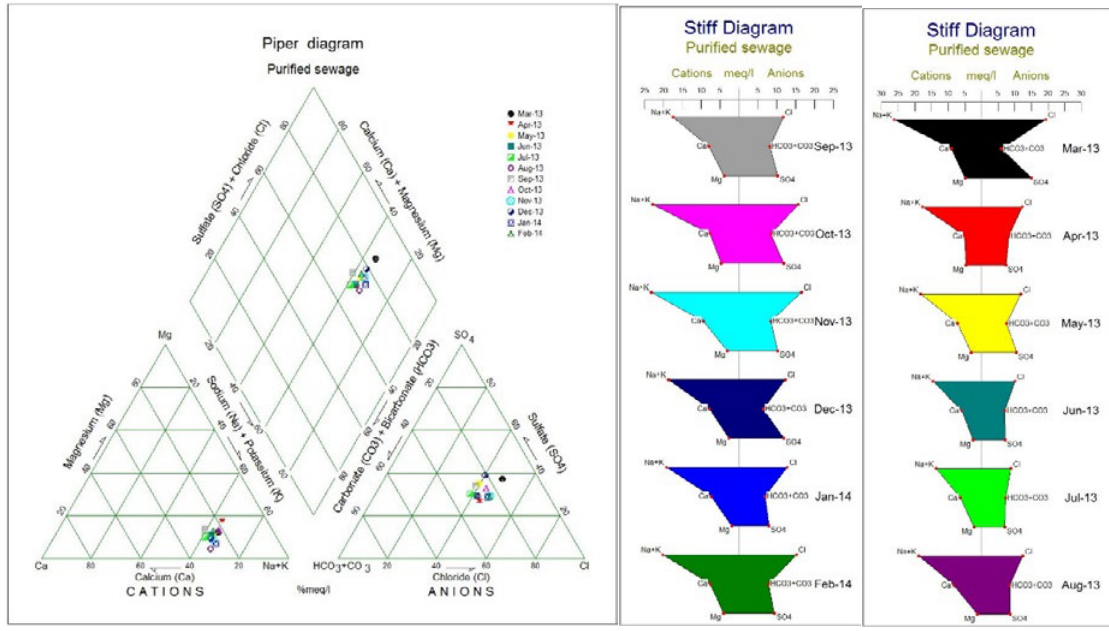
Fig. 4: Piper and Stiff diagrams of the samples collected from the treated wastewater in Qom